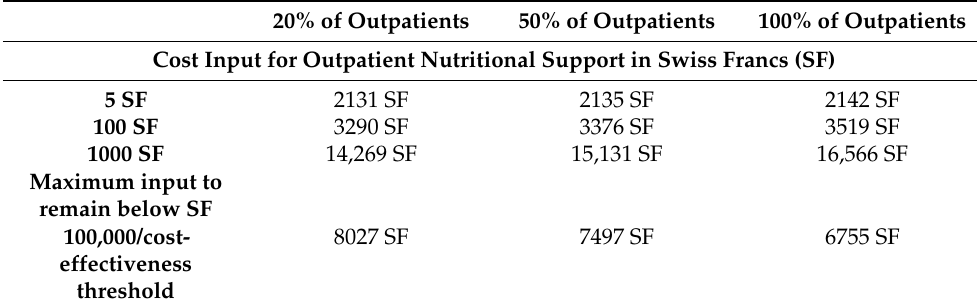
Table A4. Sensitivity analysis results for ICER per